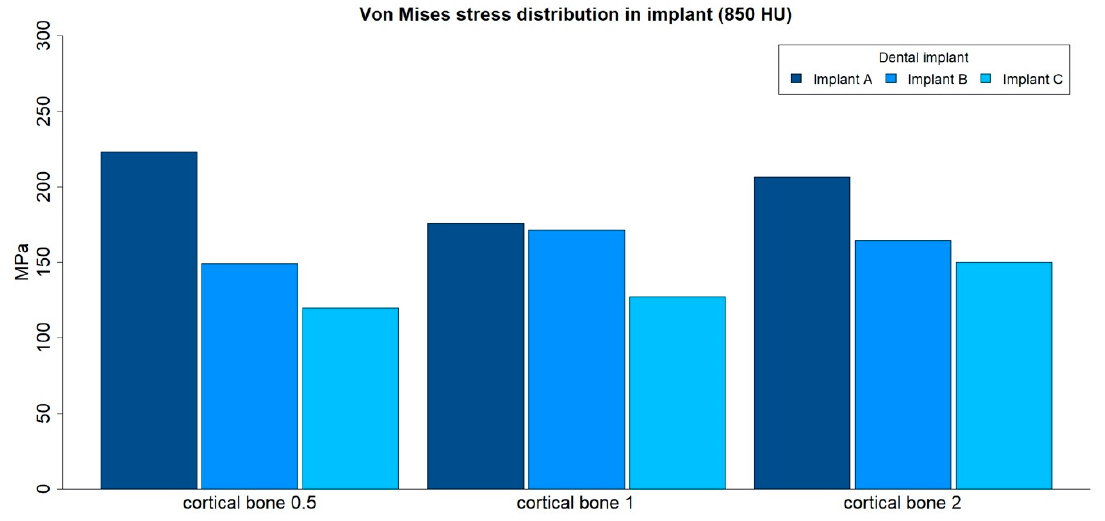
Figure 13. von Mises stress distributions (MPa) in implants, in high-density medullar bone (850 HU), for all cortical thicknesses (0.5 mm, 1 mm, and 2 mm) in all implant designs: A, B, and C. Table 5. von Mises stress distributions (maximum absolute values, MPa) in implants, for both medullar bone densities, for all cortical thicknesses (0.5 mm, 1 mm, and 2 mm) in all implant designs: A, B, and C.